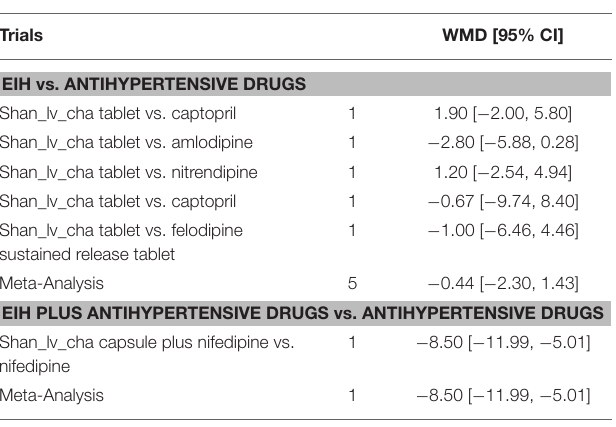
TABLE 5 | Analyses of systolic blood